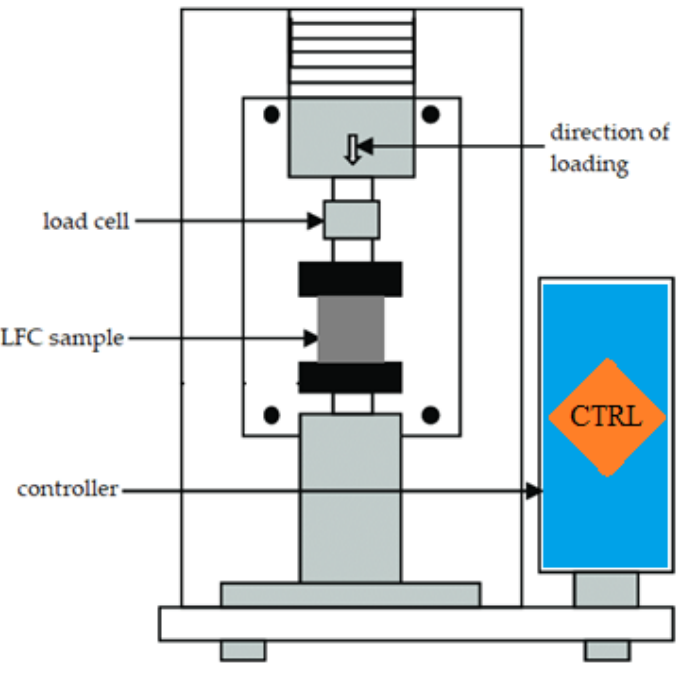
Figure 5. Schematic diagram of the compression test